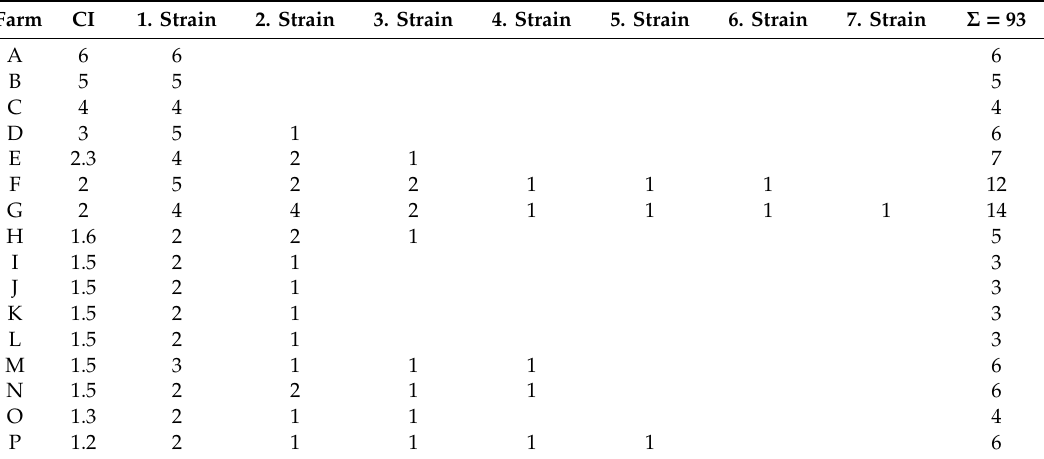
Table 1. The number of isolates and strains of Streptococcus dysgalactiae on each